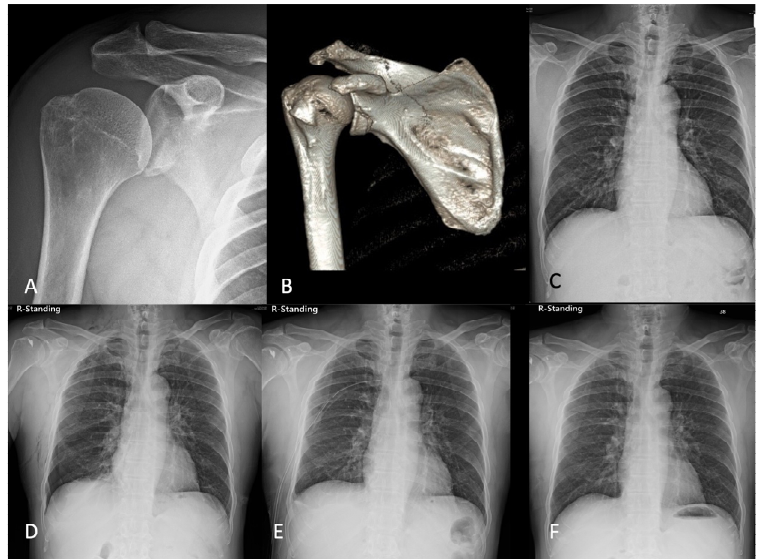
Figure 2. A 58-year-old male with ( A , B ) Right anterior glenoid fossa fracture, Ideberg type Ia. ( C ) Preoperative chest X-ray was unremarkable. ( D ) Right pneumothorax was found incidentally. ( E ) A chest tube was placed. ( F ) Follow-up chest radiography displayed improved right lung expansion.